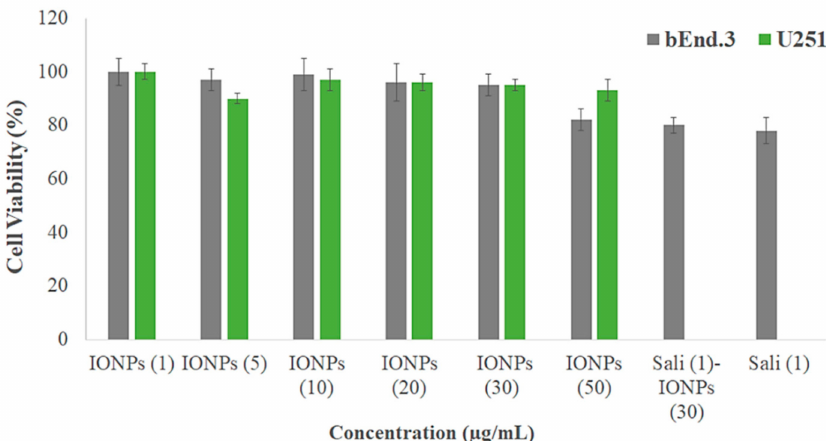
Figure 2. Biocompatibility of di ff erent concentrations of PEI-PEG-IONPs (termed IONPs) on mouse brain-derived microvessel endothelial (bEnd.3) and U251 cell lines after 48 h treatment using MTT assay ( n = 5). The Y -axis represents cell viability compared to the control.